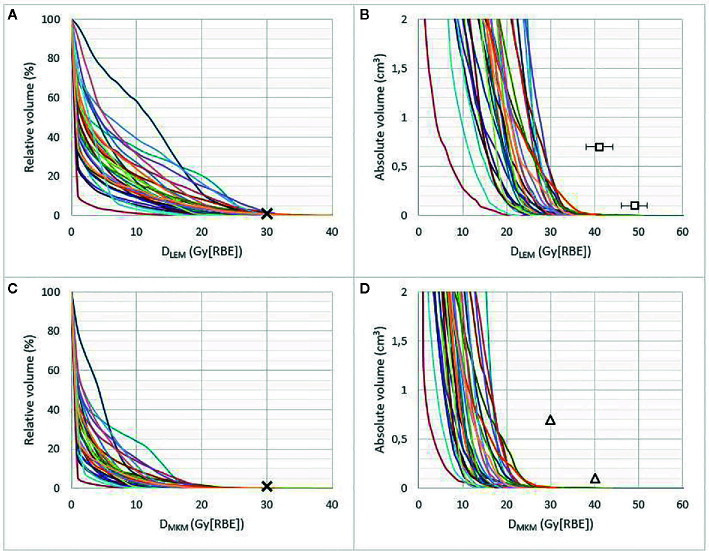
Brainstem DVHs in relative (A, C) and absolute volume (≤2 cm3) (B, D) of 30 patients treated at CNAO, presented in D
LEM I
(A, B) and D
MKM
(C, D). Crosses represent the former CNAO and NIRS dose constraint of D
1% ≤30 Gy (RBE). Triangles represent the new D
MKM constraints V
40 Gy (RBE) <0.1 cm3 and V
30 Gy (RBE) <0.7 cm3 as defined by Shirai et al. (14). Squares in (B) represent the possible new D
LEM I constraints (error bars, 95% CI) resulting from the dose translation model presented in this work, see
Figure 3
.